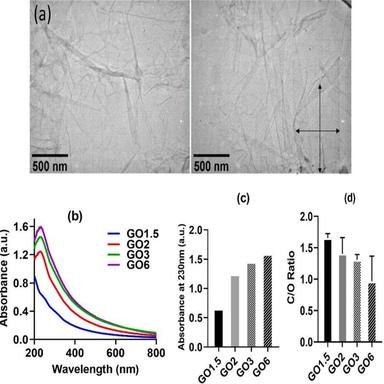
Characterization of Nanomaterials: (a) TEM image of GO3, highlighting the borders of a single sheet with arrows. (b) UV–visible spectra of GO samples with varying oxidation degrees (GO1.5 to GO6) at equal concentrations. (c) Diagram illustrating the increased absorption at 230 nm for GO samples with oxidation degrees ranging from GO1.5 to GO6. (d) Diagram showing the carbon to oxygen ratio of GO samples (GO1.5 to GO6) determined through EDS elemental analysis.